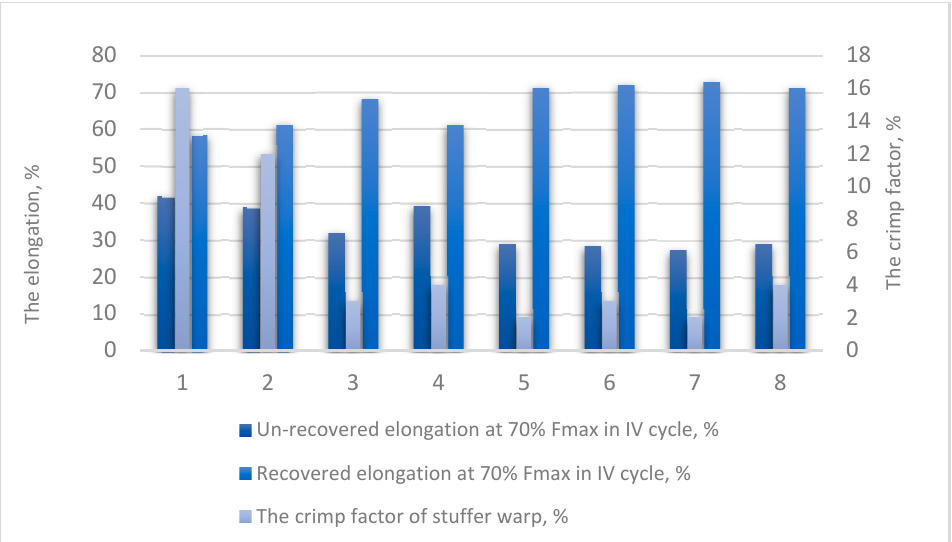
Figure 7. Summary of elongation and the crimp factor for tested fabrics.